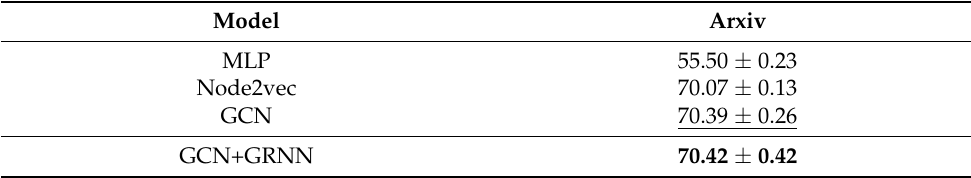
Table 8. Summary of classification accuracy (%) results on